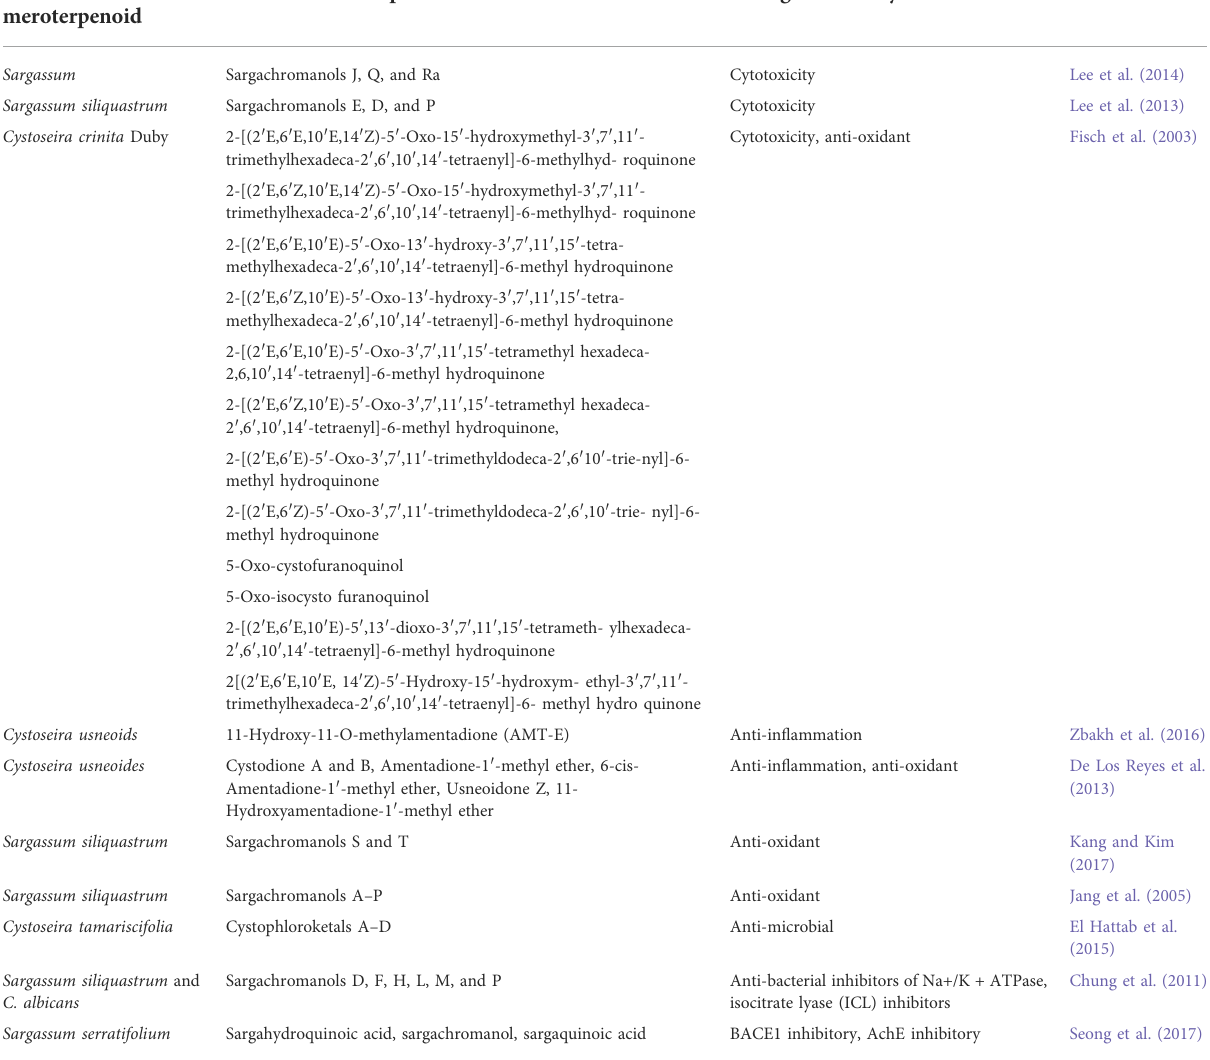
TABLE 4 Sources and biological activity of algae